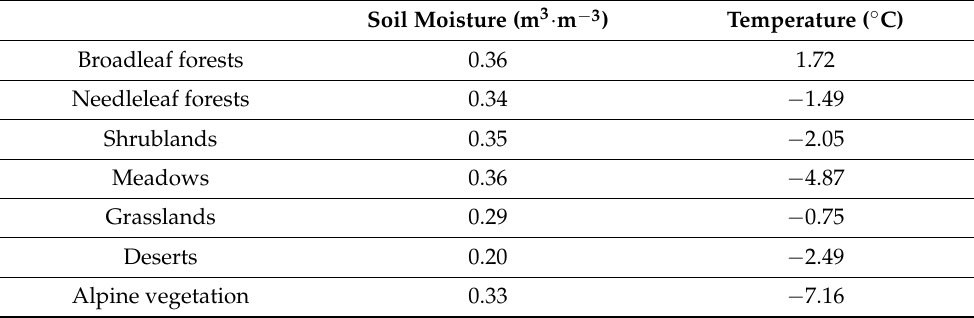
Table 3. The annual average soil moisture and temperature from 2001 to 2020 for different vegeta- tion